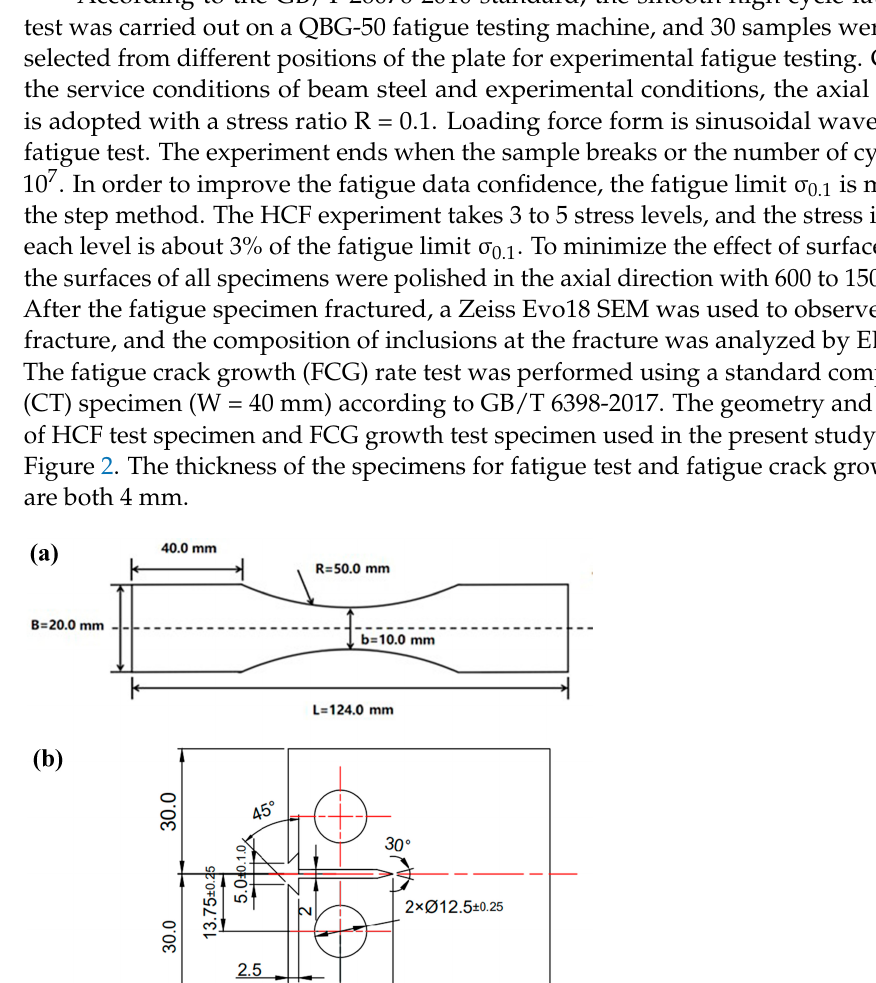
Table 1. The chemical compositions of the experimental steels (wt.%).